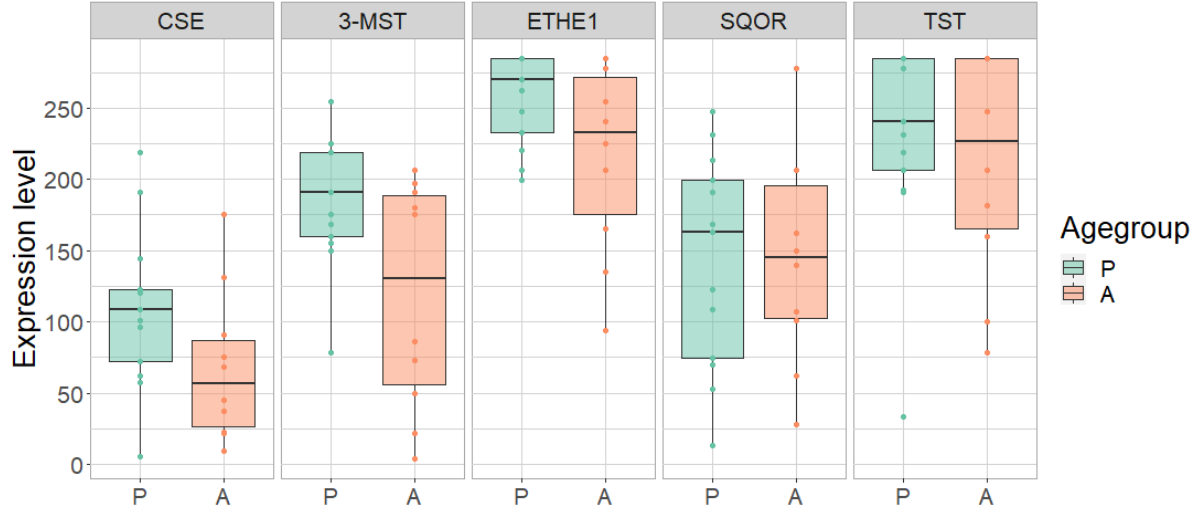
Figure 4. Expression of cystathionine- γ -lyase (CSE), 3-mercapto-sulfurtransferase (3-MST), ethylmalonic encephalopathy 1 protein (ETHE1), sulfide:quinone oxidoreductase (SQOR) and thiosulfate sulfurtransferase (TST) in pediatric (P) and adult (A) samples in the rectum of pediatric (P) and adult (A) healthy controls. Range of expression levels from a minimum of 0 to a maximum of 300. Table 3. Expression as mean with standard deviation (SD), absolute reduction and percentage as well as p -value of the rectum of the healthy control group (C) separated by age group. Pediatric (P); adult (A). cystathionine- γ -lyase (CSE), 3-mercapto-sulfurtransferase (3-MST), ethylmalonic enceph- alopathy 1 protein (ETHE1), sulfide:quinone oxidoreductase (SQOR) and thiosulfate sulfurtransfer- ase (TST).